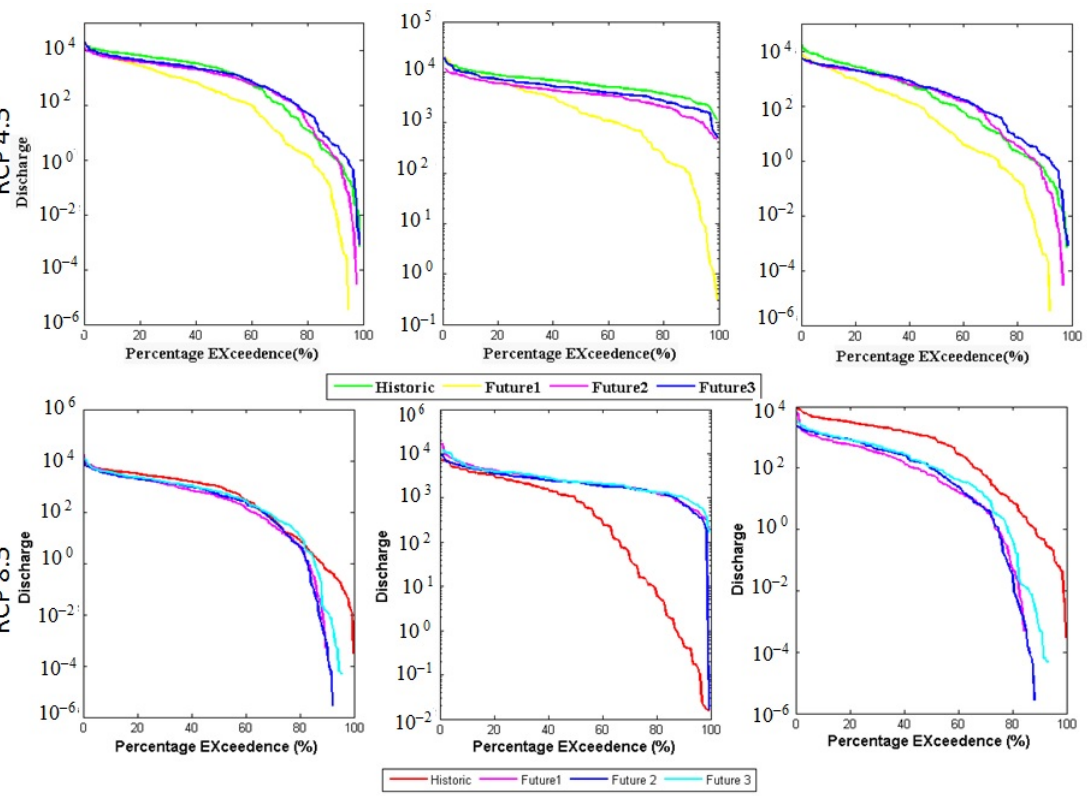
Figure 10. Annual, monsoon, and non-monsoon flow duration curves at the Pondhugala gauge station for historic and future periods under RCP 4.5 and RCP 8.5 scenarios.